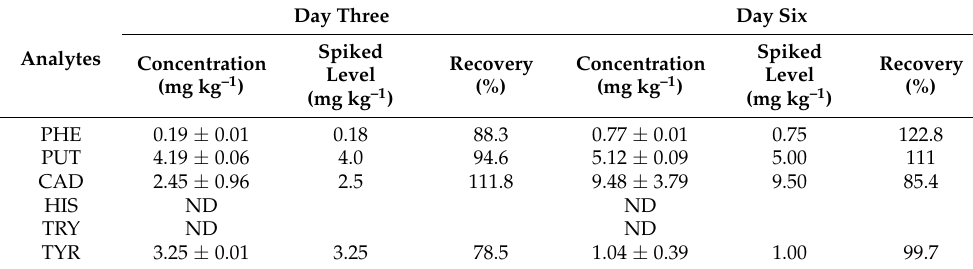
Table 3. Recovery of biogenic amines in pork on day three and six.